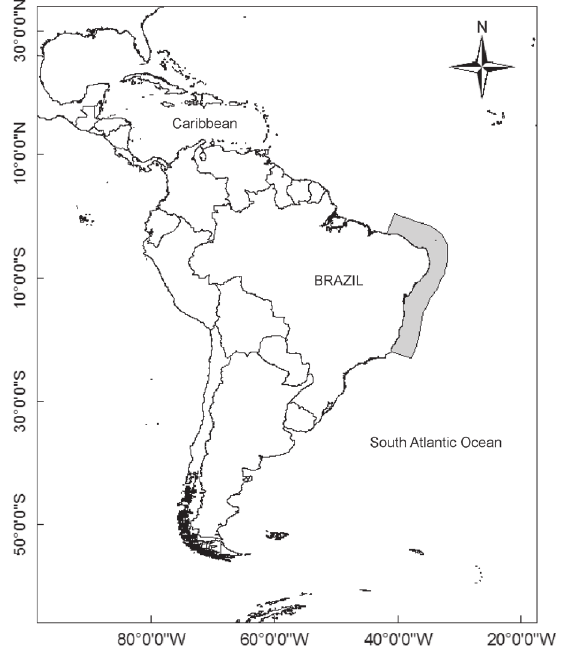
Fig . 1. – Location of the East Brazil Large Marine Ecosystem (gray) along the Brazilian